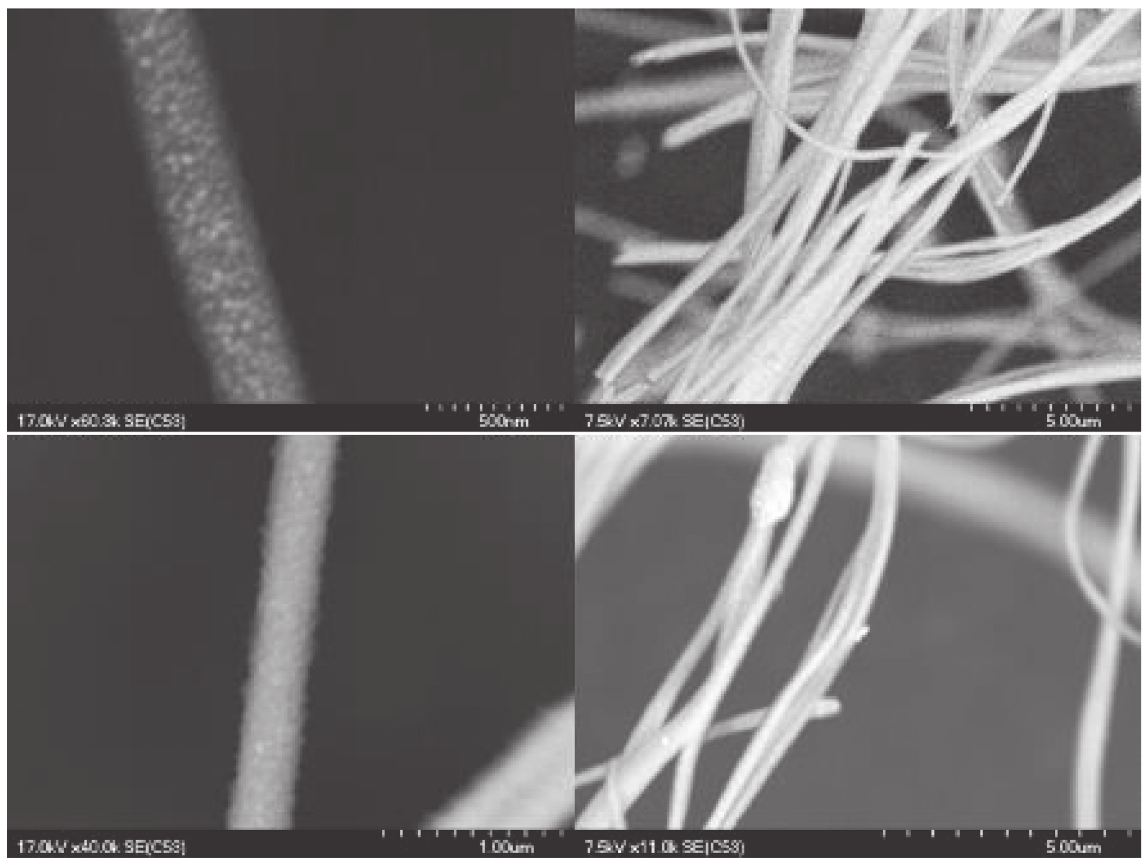
Figure 6: SEM images of as-spun HfC fibers after carbonization.